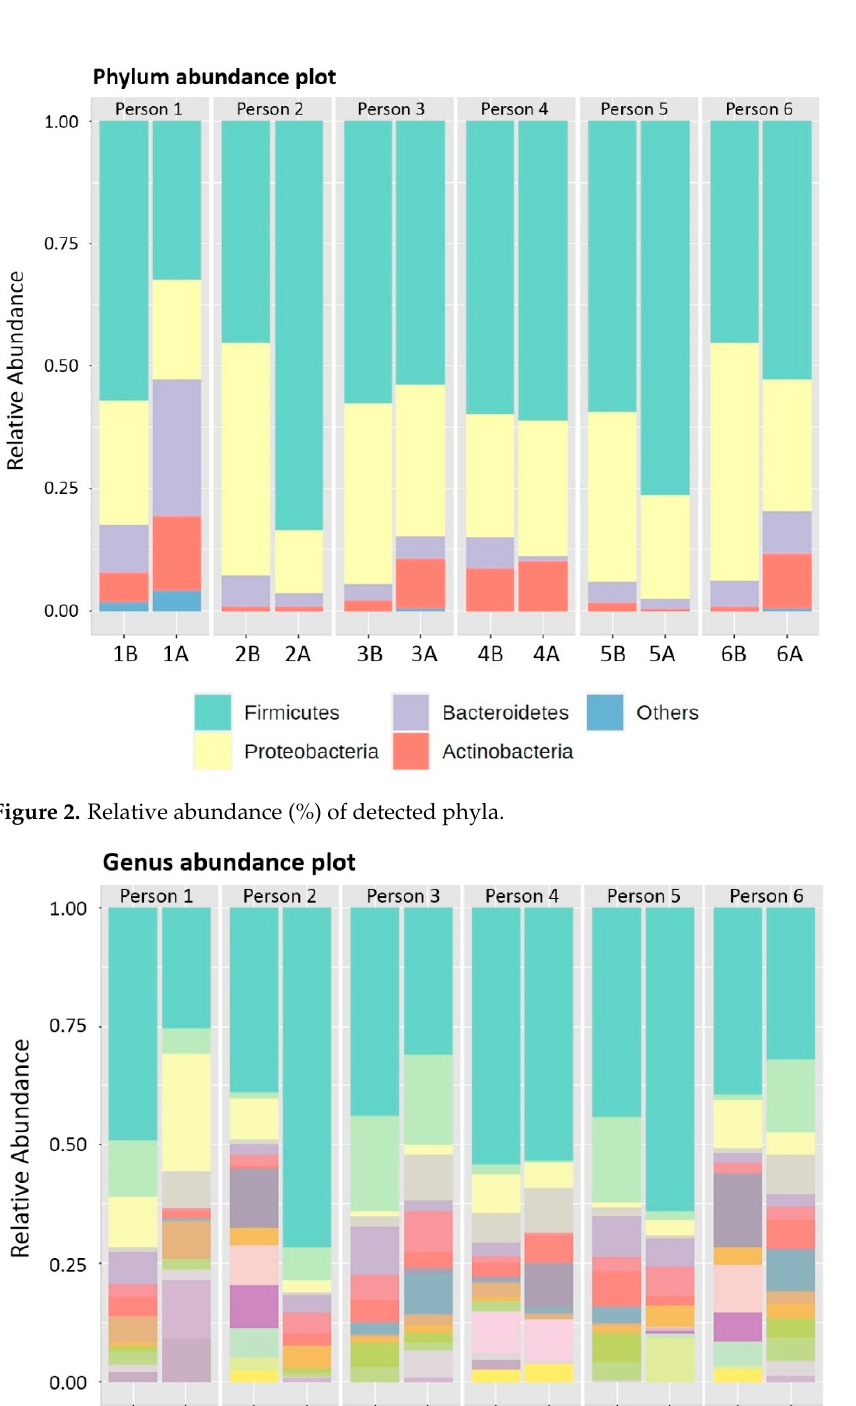
Figure 4. Relative abundance (%) of detected species.